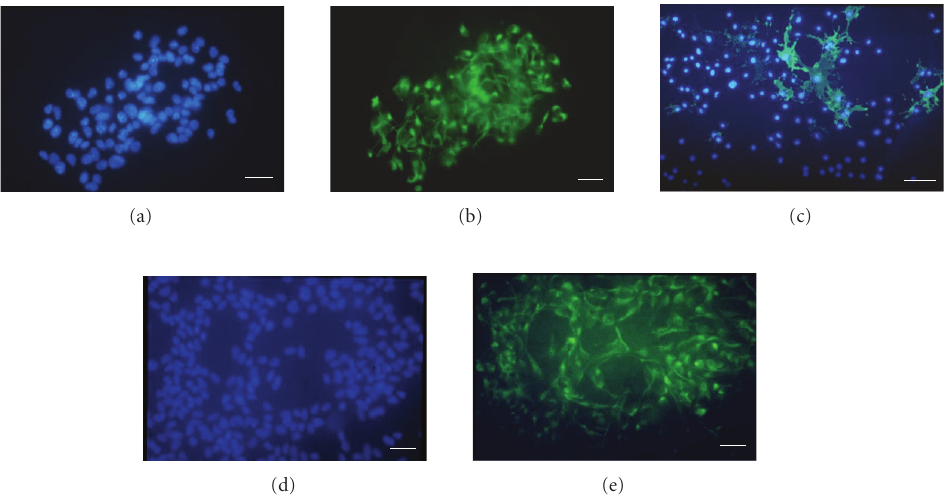
Figure 2: Immunolocalization in S0 neurospheres of nestin (b) and PLP (e). Nuclear staining of the same field is shown in (a) and (d), respectively. Double A2B5/Hoechst immunostaining is shown in (c). Bar = 70 μ